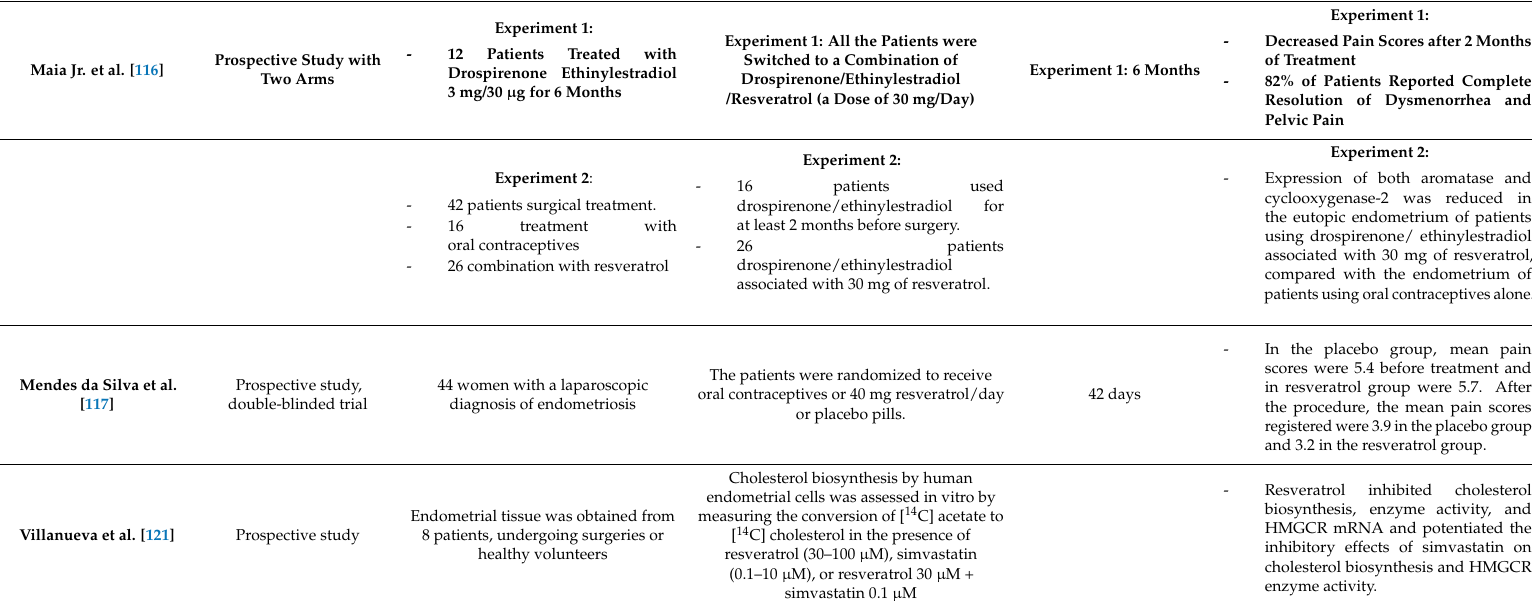
Table 2. Clinical studies regarding the effects of resveratrol in